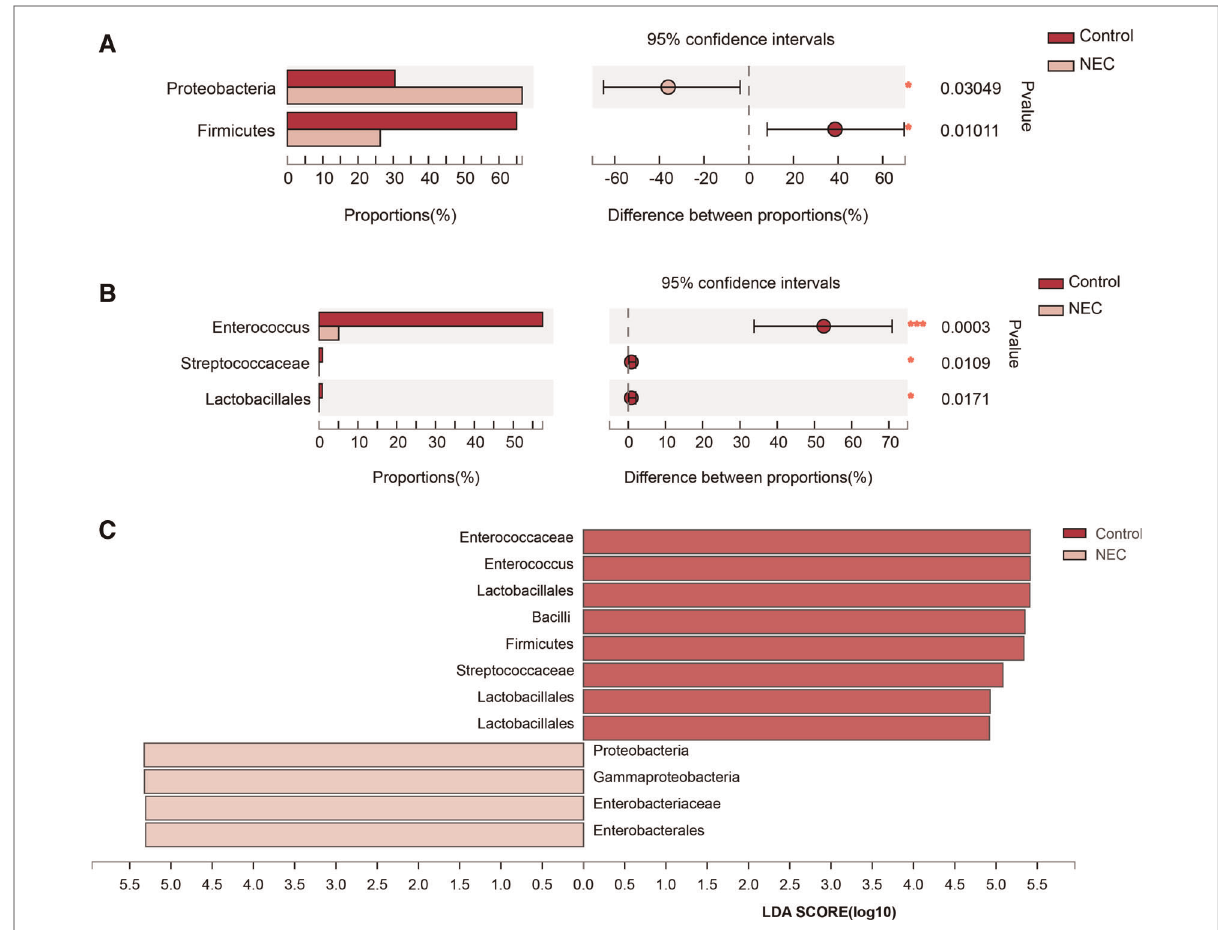
FIGURE 4 Analysis of signi fi cant species differences: ( A ) Species with signi fi cant differences at the phylum level; ( B ) Species with signi fi cant differences at the genus level; ( C ) LDA scores for gut